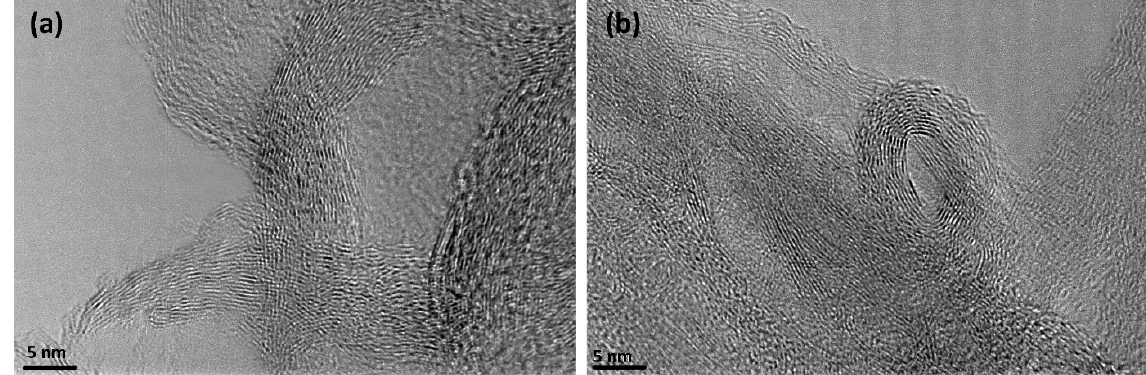
Figure 4. Transmission electron microscopy (TEM) image of N-doped graphene showing graphene layers: ( a ) 60 s of treatment, and ( b ) 105 s of treatment.